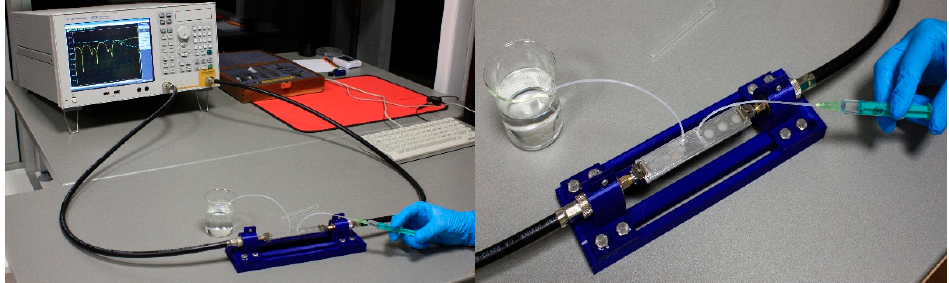
Figure 8. Measurement setup of the proposed sensor.